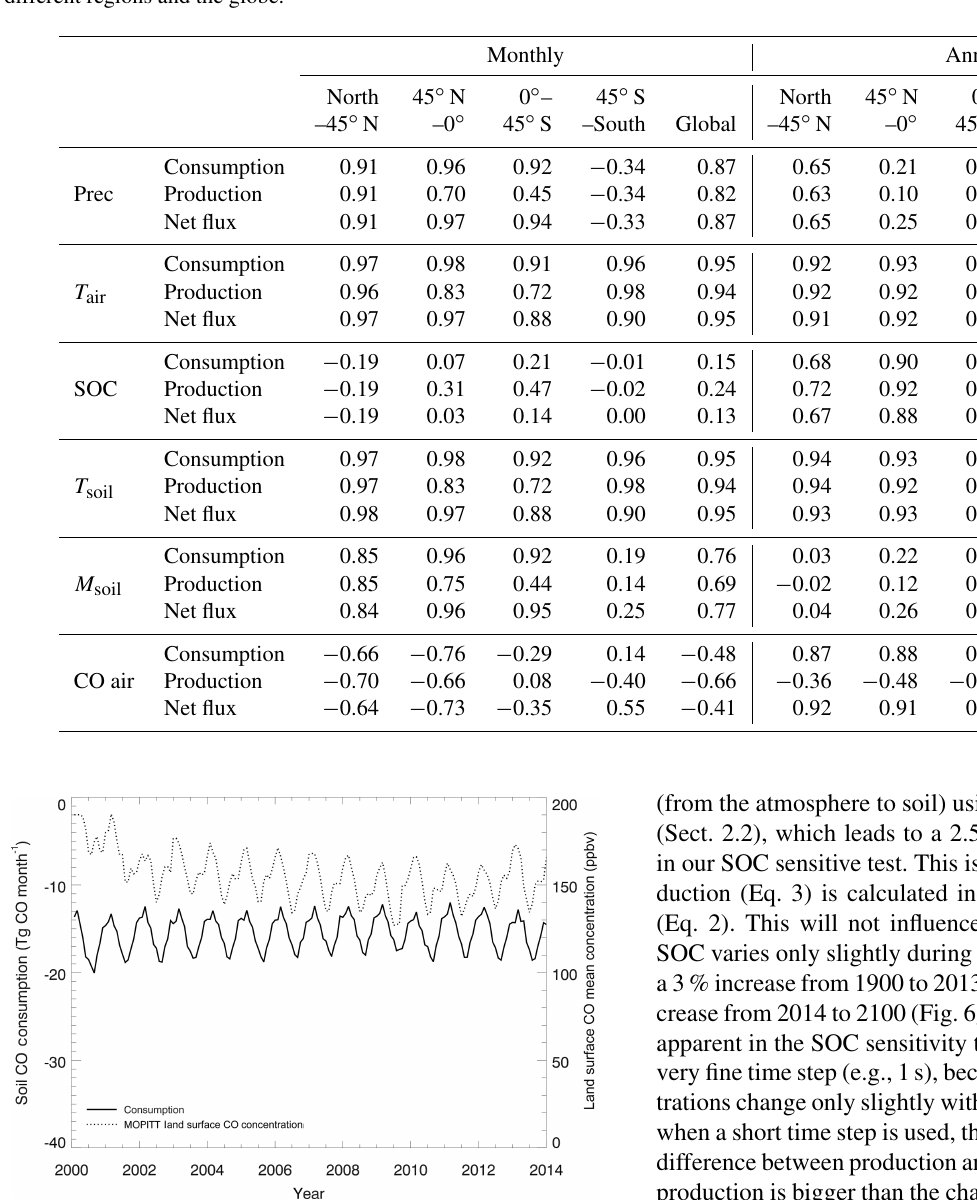
Table 6. Correlation coefficients between forcing variables (precipitation (Prec), air temperature ( T air ), soil organic carbon (SOC), soil temperature ( T soil ), soil moisture ( M soil ) and atmospheric CO (CO air)) and absolute values of consumption, production and net flux for different regions and the globe.